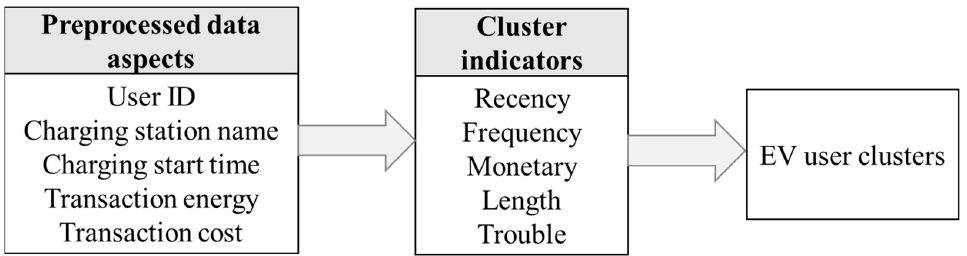
Figure 7. Overview of K-means based EV clustering method proposed in [18].